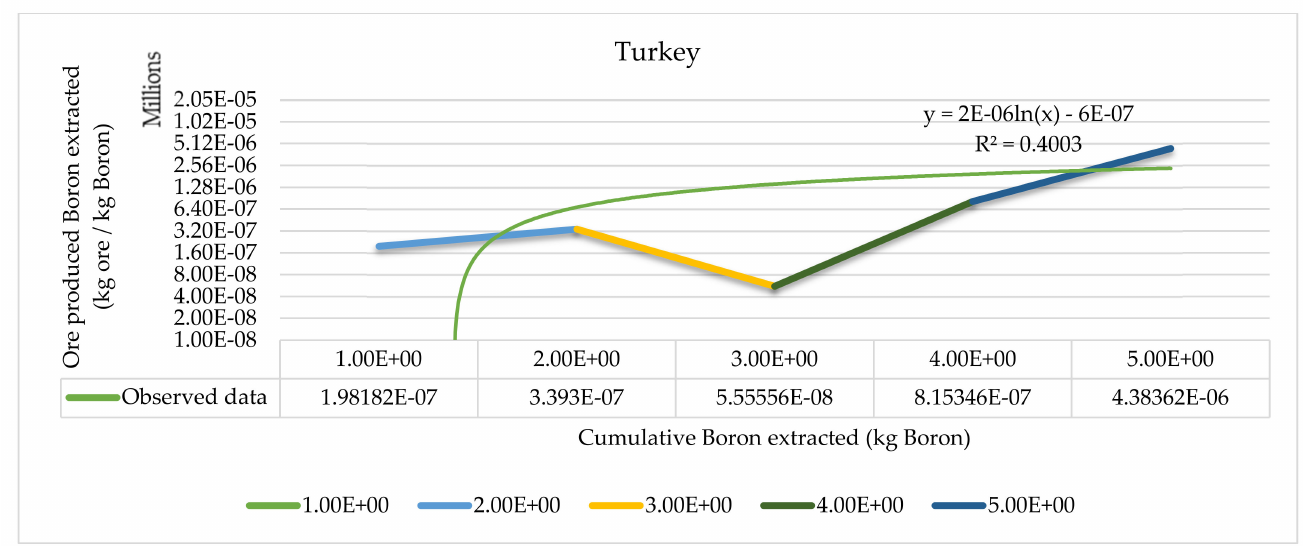
Figure 4. Cumulative grade-tonnage relationship plotted using a log-logistic regression (on a loga- rithmic scale) for existing boron mines. (In